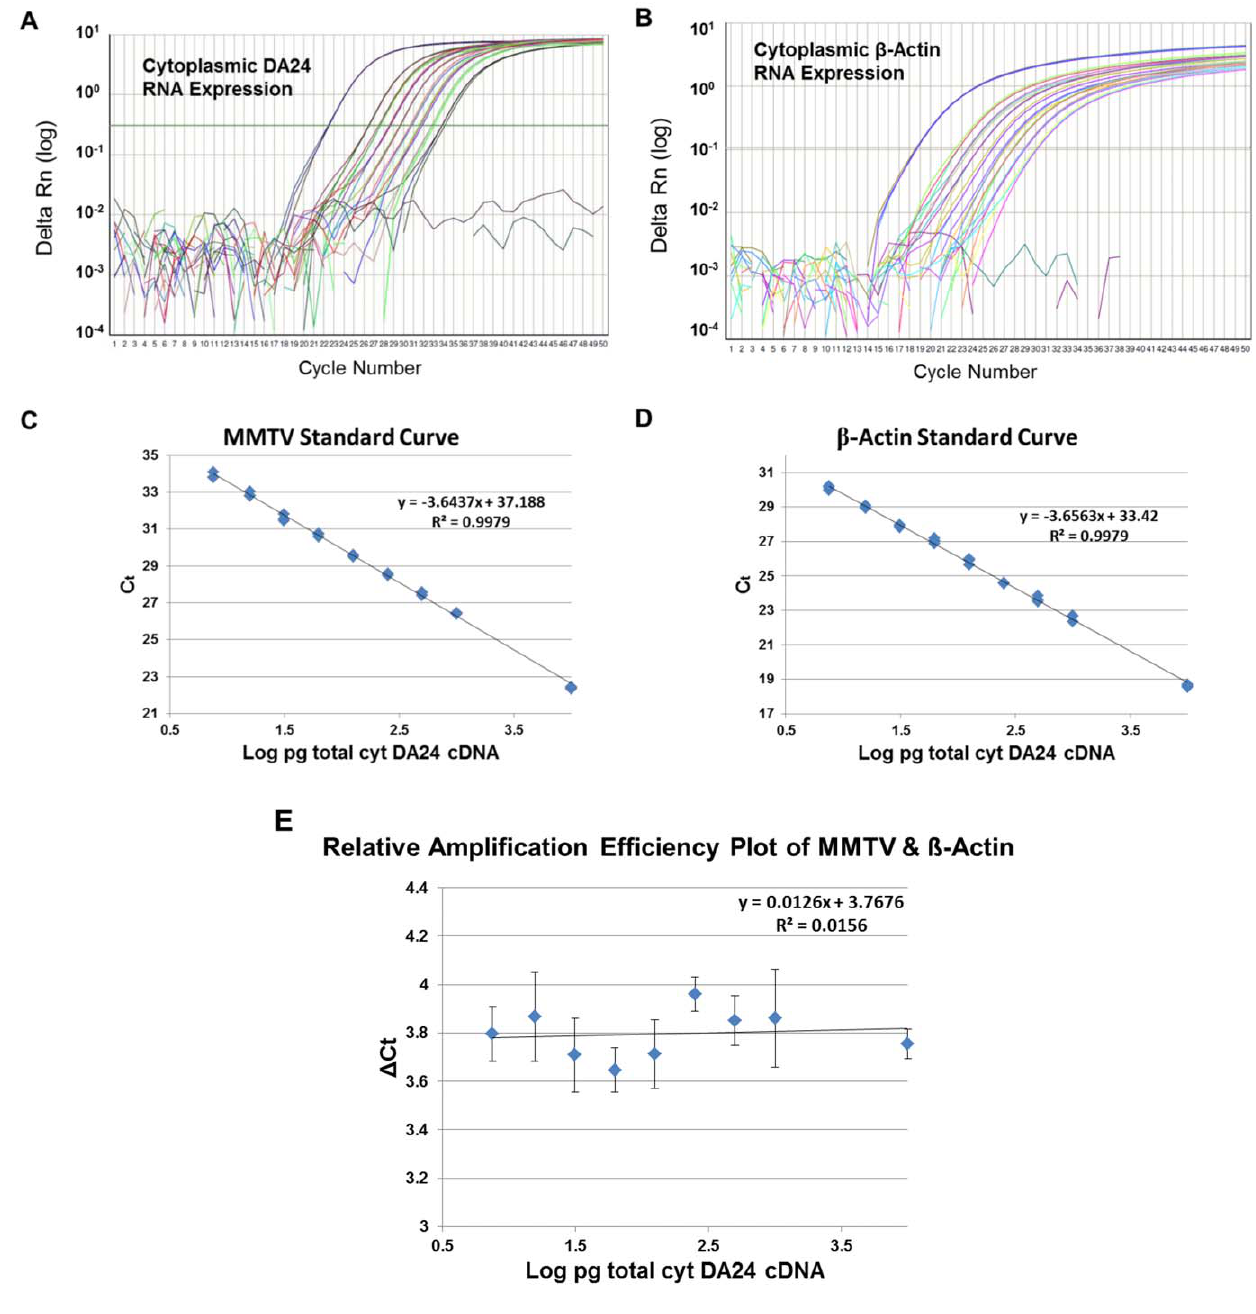
Figure 3. Validation of the real time PCR assay developed for relative quantification of transfer vector RNA expression using the Ct slope method. Determination of the threshold cycles (Ct) of the cDNA prepared from 293T cytoplasmic RNA expressing transfer vector DA24 tested in triplicates as 10- and 2-fold dilutions by the ( A ) custom-made MMTV Taqman assay, and ( B ) the ß-actin Taqman assay. D Rn is the target gene- specific fluorescence signal (FAM for MMTV-specific and VIC for ß-actin-specific sequences) normalized to the signal for the internal passive control, ROX (Normalized Reporter or Rn) from which the baseline target fluorescence has been subtracted ( D Rn=Normalized Reporter (Rn) - baseline). Standard curves of the ( C ) MMTV and ( D ) ß-actin Taqman assays were generated to determine their D Ct values (Ct values of the MMTV assay – Ct value of the ß-actin endogenous control) that were needed to allow comparison of amplification efficiencies of the two assays. ( E ) Relative amplification efficiencies of the two assays as determined by the analysis of D Ct value variations with the amount of input template cDNAs. For the two assays to have similar amplification efficiencies, the value of the slope of log input amount verses D CT should be approximately zero ( , 0.1), which under our experimental conditions were calculated to be 0.0126, thus validating the assay for the relative quantification analysis.